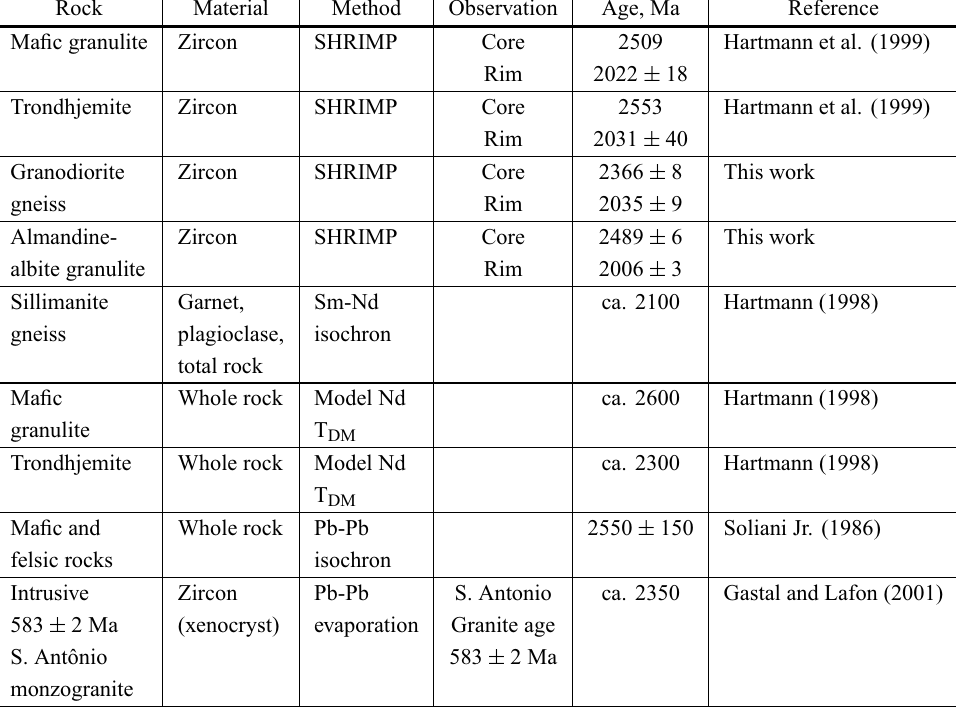
Geochronological data available on Santa Maria Chico Granulitic